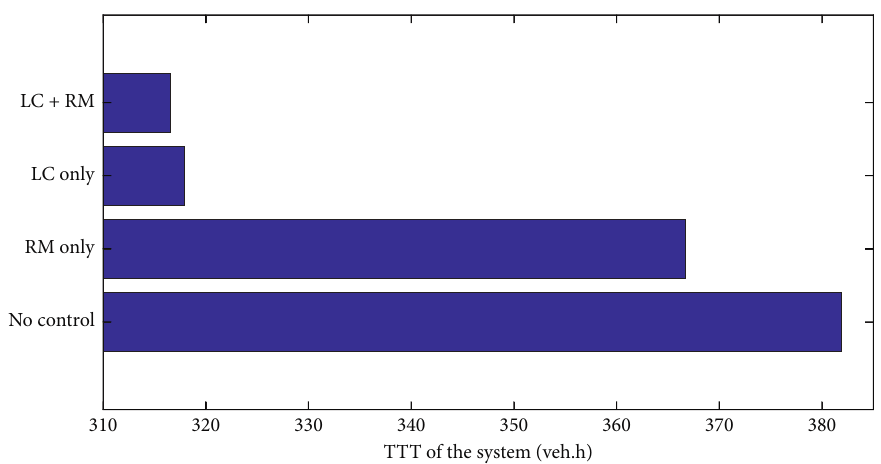
Figure 3: Comparison of the TTT of the